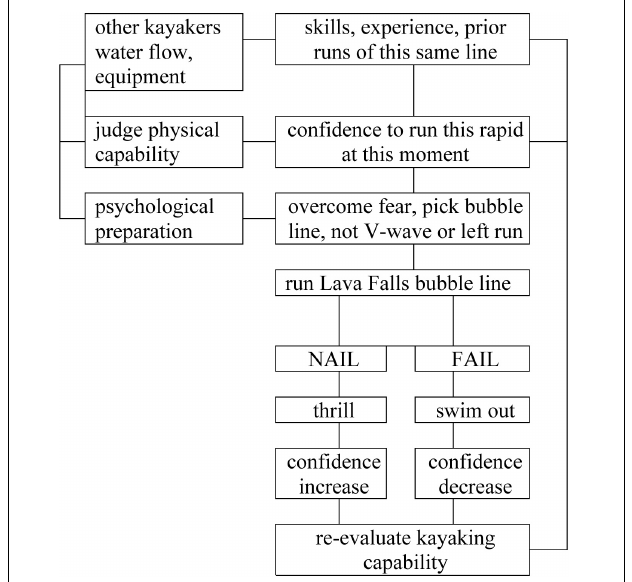
FIGURE 1 | Nail or fail the Lava Falls bubble